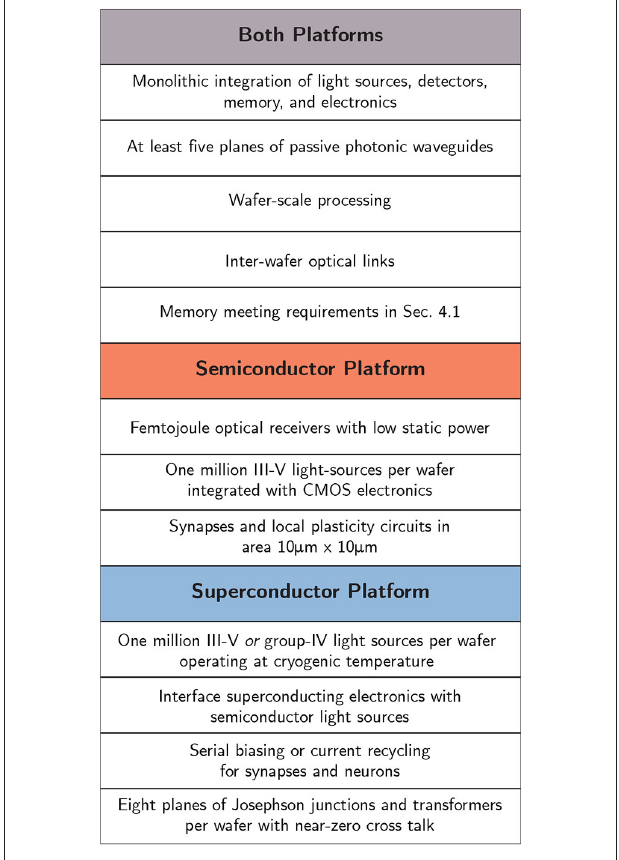
FIGURE 7 | Summary of necessary hardware demonstrations for each platform if human-brain-scale artificial cognition is to be